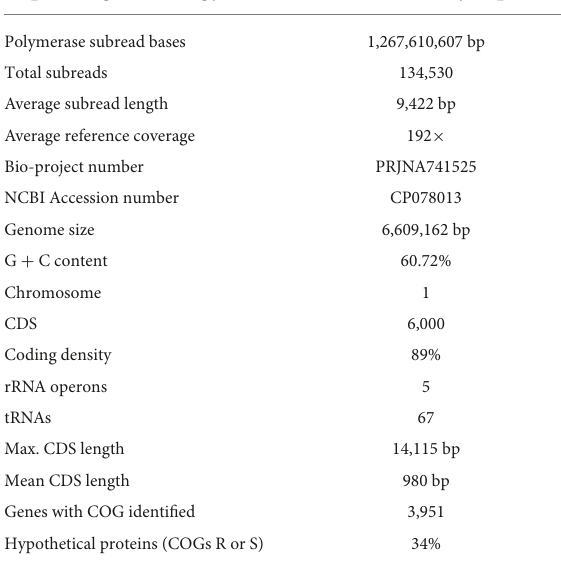
TABLE 3 Description of the sequenced, assembled, and annotated whole genome of Pseudomonas sp. strain 1008. Sequencing